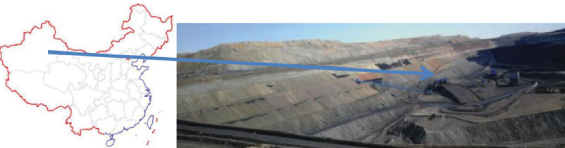
Figure 1: Compound slope of BP